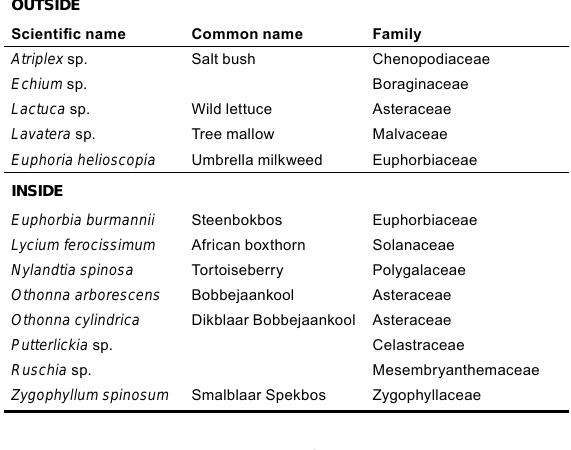
tAble 3 Monthly average temperature (°C) and precipitation (mm) during the hottest months of summer at Langebaan over a 30-year period (SA Weather Service, 26 October 2006), compared with that of the previous two summers at the time of the